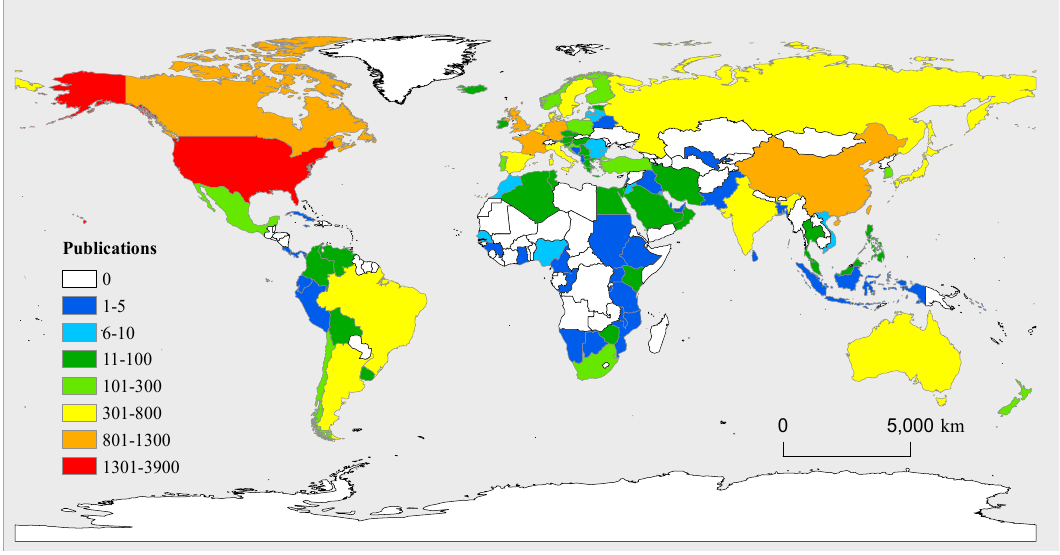
Figure 3. Distribution map of worldwide research on diatom from 1991 to 2018 based on number of publications.